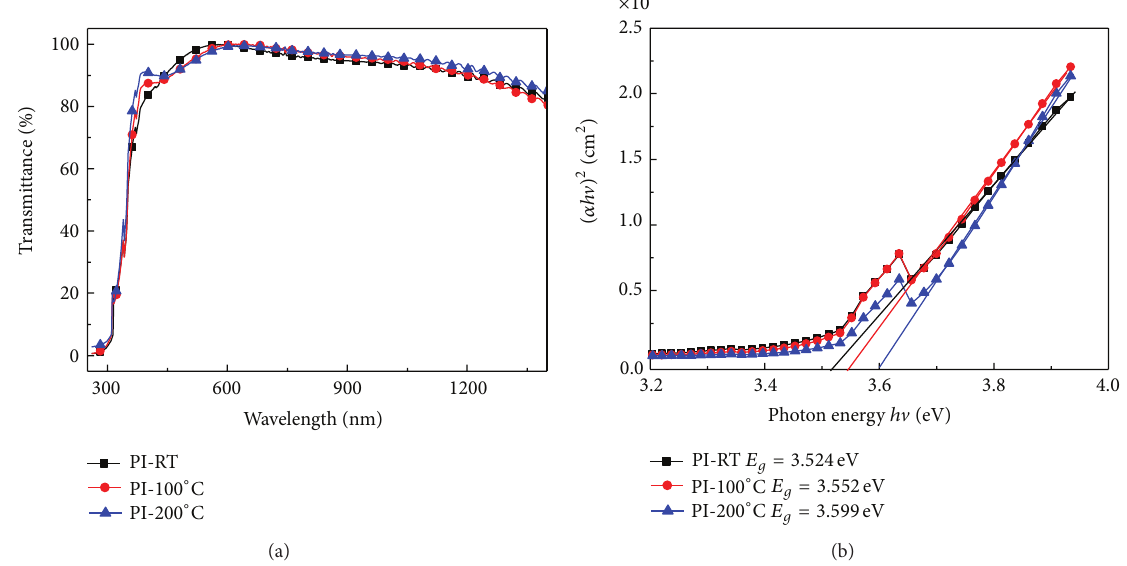
Figure 5: (a) Transmittance and (b) (𝛼ℎ ] ) 2 versus ℎ ] − 𝐸